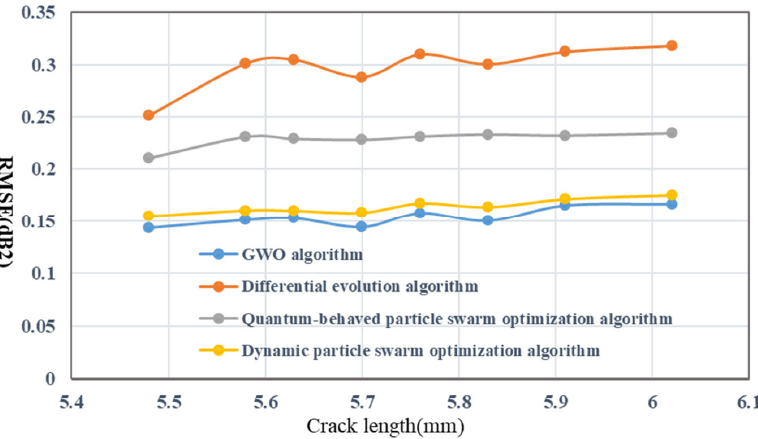
Figure 8. RMSEs of four strain reconstruction algorithms for different crack lengths.